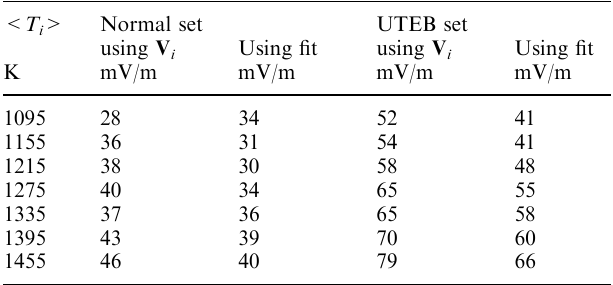
bins of Fig. 5 i